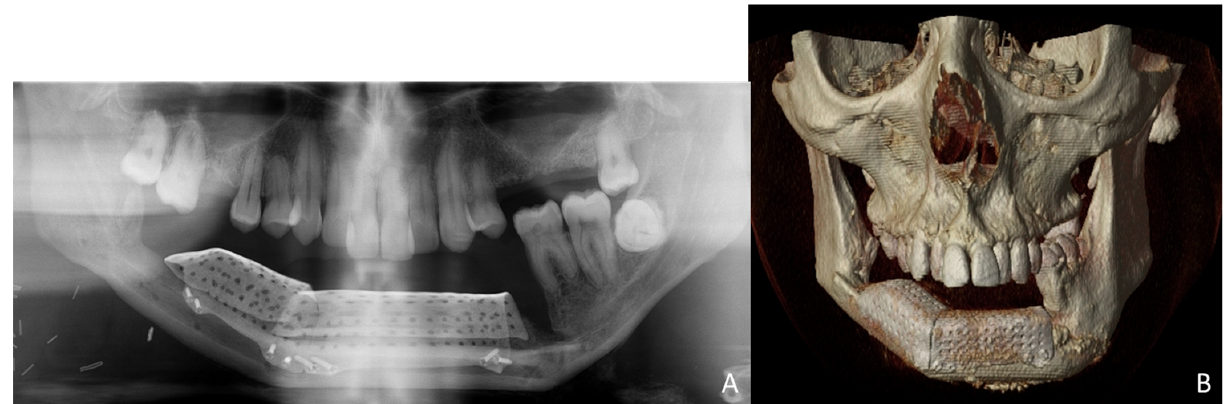
Figure 6. Postoperative images after 3D reconstruction with CAD/CAM titanium mesh and iliac crest graft. ( A ) Panoramic radiograph showing the vertical reconstruction of the symphysis and both mandibular bodies with the iliac crest graft. ( B ) CT Scan with three-dimensional reconstruction of the mandible.